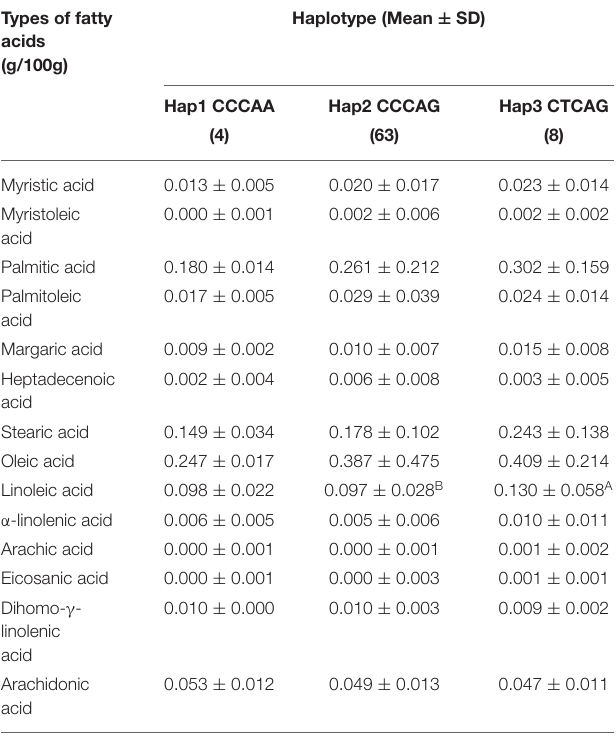
TABLE 5 | Association analysis of three haplotypes and fatty acids in Chinese Simmental Cattle. Types of fatty